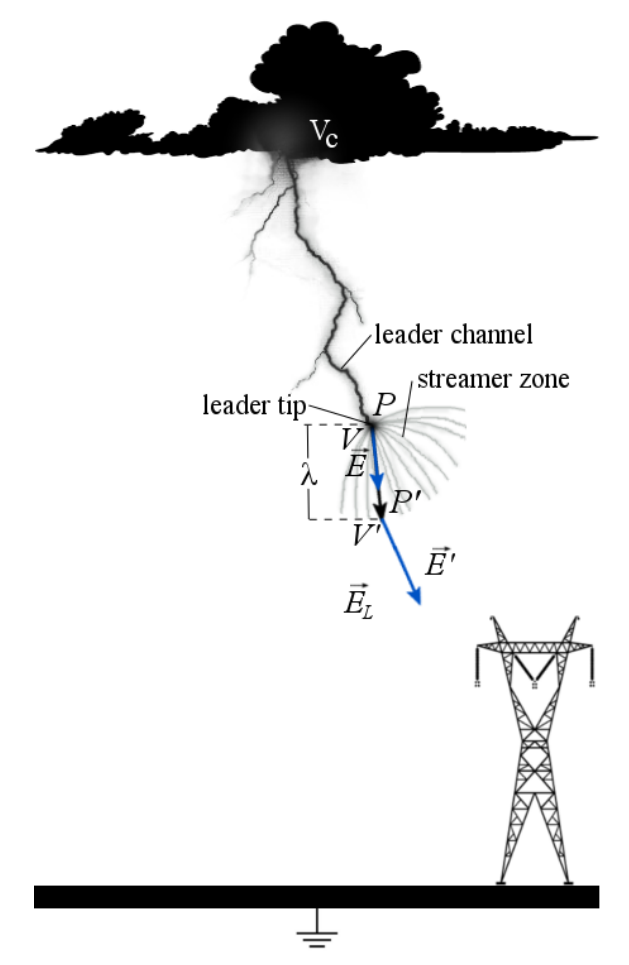
Figure 2. Diagram of the downward leader as described by the